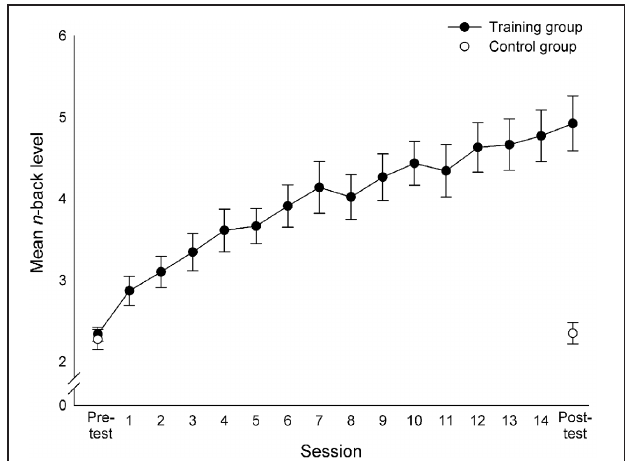
FIGURE 3 | The number of correctly reported four-item sequences in the VS updating task. Performance for both groups is illustrated separately for pre-test and post-test. Error bars indicate standard errors of the